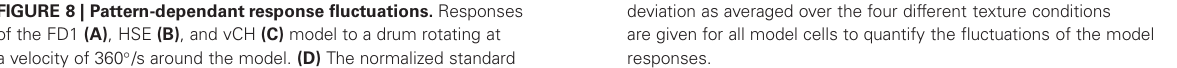
deviation as averaged over the four different texture conditions are given for all model cells to quantify the fluctuations of the model